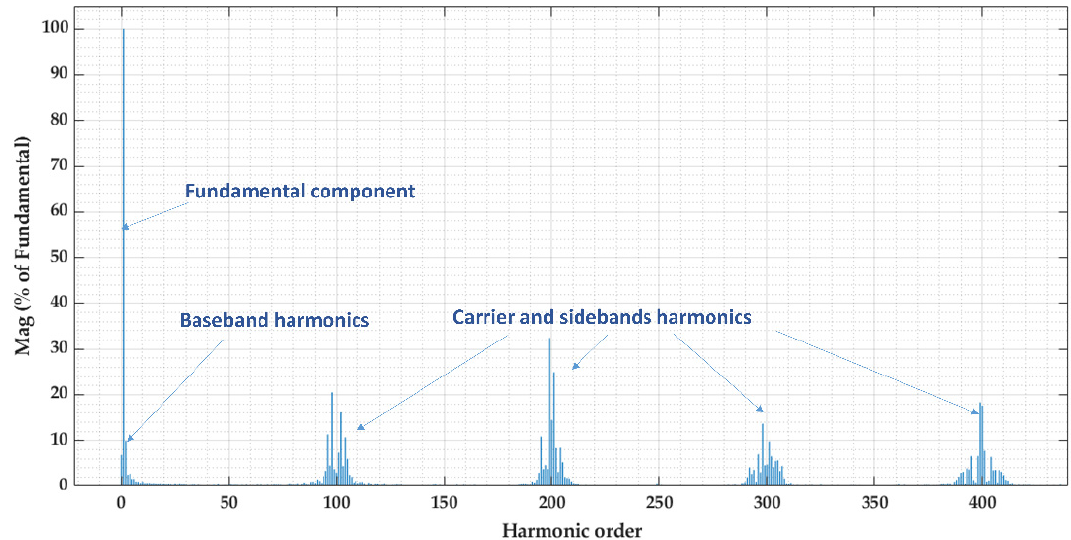
Figure 4. Harmonic content of the measured output voltage of a 6 kW and 5 kHz three-phase inverter.